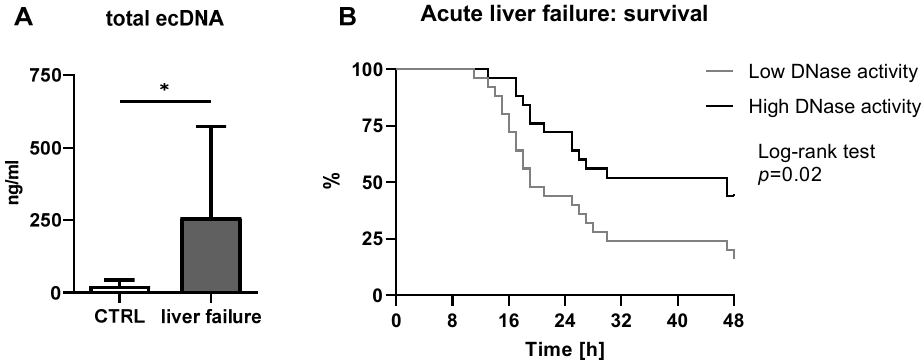
Figure 1. ( A ) The extracellular DNA (ecDNA) is higher in acute liver failure in comparison to the control group (unpaired t -test; p = 0.01; t = 2.74). ( B ) The survival of mice with low and high endogenous DNase activity were assessed (log-rank test; p = 0.02). *— t -test with p < 0.05. Median DNase activity in mouse plasma was 3.7 K.u./mL. This was used to divide